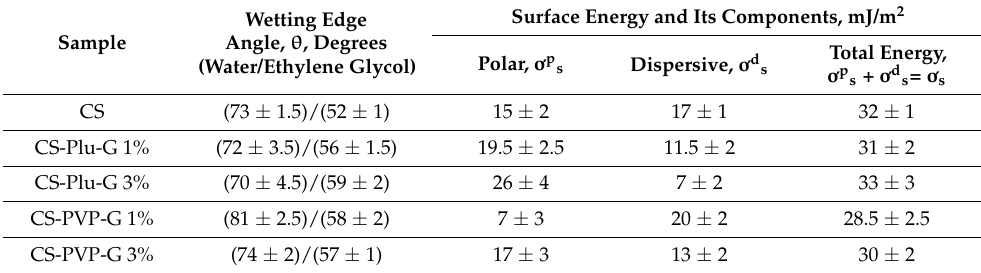
Table 1. Surface energy of CS/graphene composite